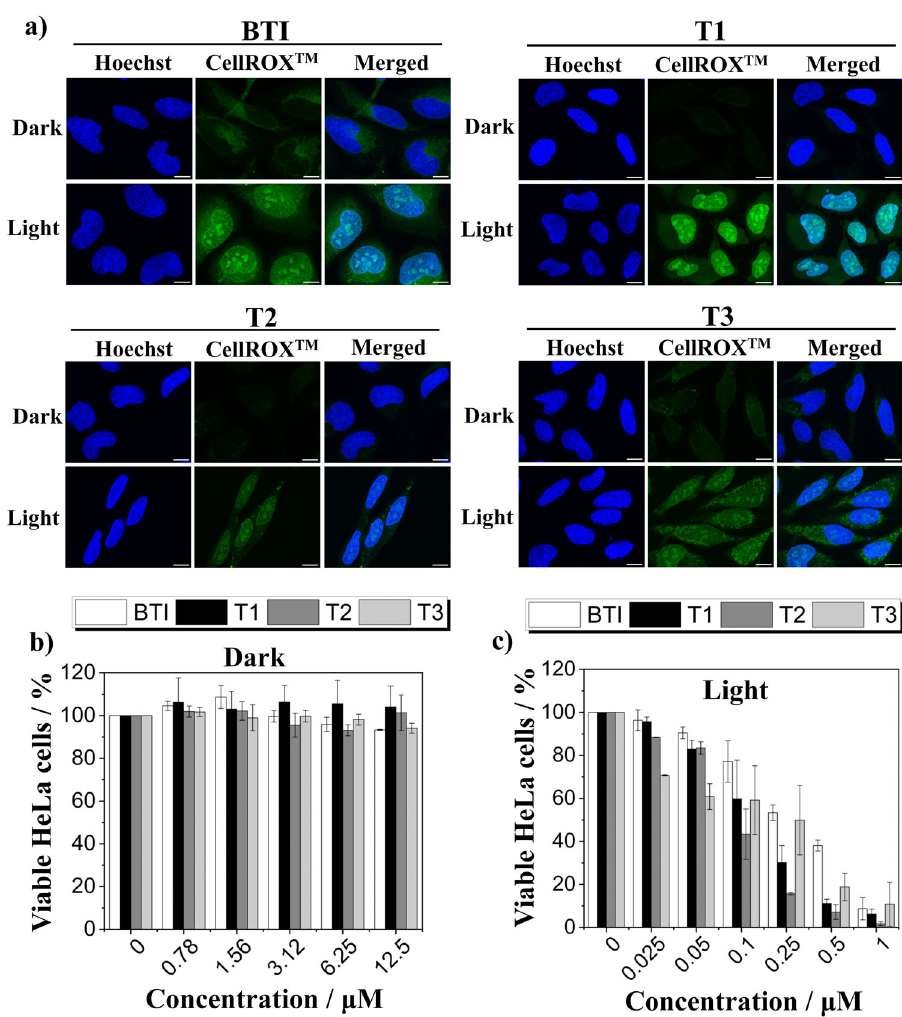
Fig. 6 Intracellular ROS production and phototherapeutic activity. a HeLa cells were treated with BTI , T1 , T2 , or T3 (500 nM) and incubated at 37 °C for 24 h. Afterwards, the cells were incubated with CellROX TM green reagent (5 µ M, green signal) for 30 min at 37 °C, and where indicated, blue light generated by a LED light cube (excitation = 470/22 nm, 23 mWcm − 2 ) was applied to the cells for 10 min. Hoechst 33342 (500 nM, blue signal) was added to the cells for 30 min at 37 °C before imaging. Hoechst 33342: λ exc / λ em : 405/430 – 460 nm and CellROX TM : λ exc / λ em : 490/510 – 670 nm. Scale bar 10 µ m. Cytotoxicity studies of BTI , T1 , T2 , and T3 on HeLa cells in the absence ( b ) or presence ( c ) of blue light (excitation = 470/22 nm, 23 mW cm − 2 ) irradiated for 6 min. n = 3 independent experiments. Mean ± SD is